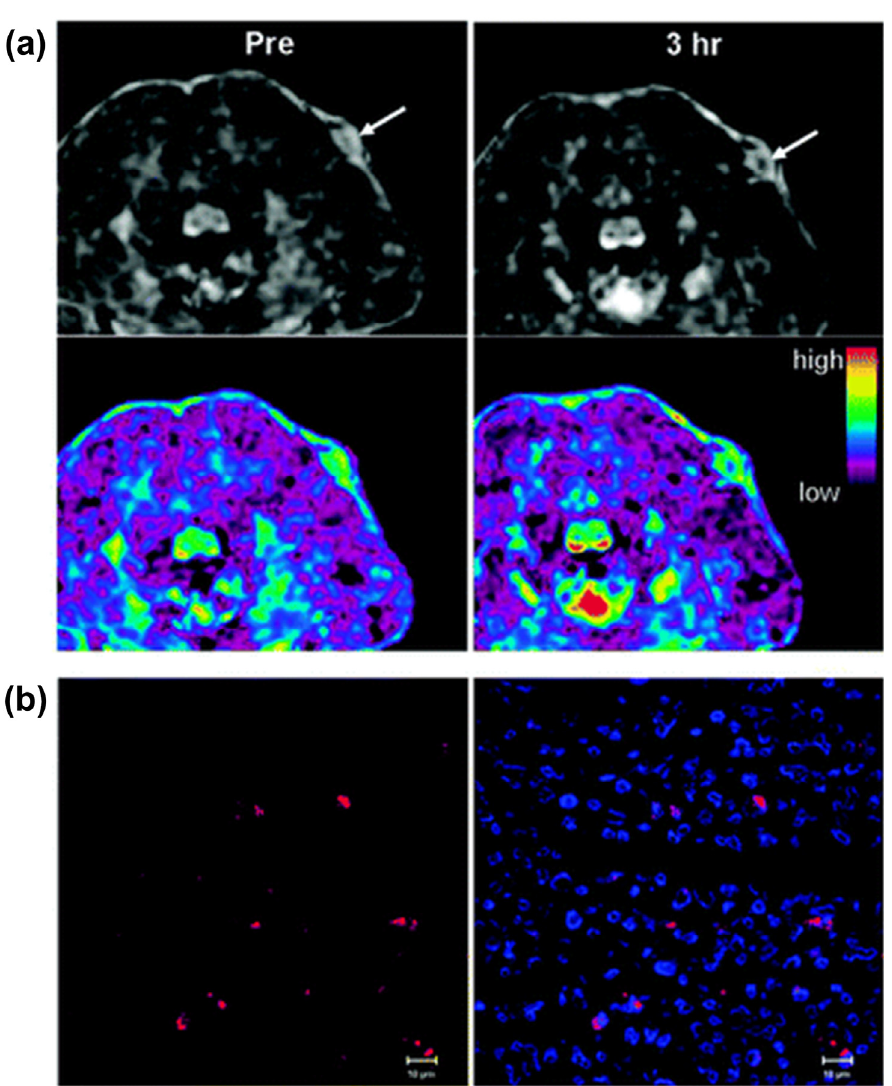
Figure 6. ( a ) In vivo MR images (upper) and color mapped images (lower) of the tumor site (indicated by arrows) before and 3 h after intravenous injection of PEG-coated Fe 3 O 4 -MSNs. ( b ) Confocal laser scanning microscopy images of sectioned tumor tissue harvested 24 h after intravenous injection of RITC-doped PEG-coated Fe 3 O 4 -MSNs (left) and merged with DAPI-stained nuclei (blue, right). Reproduced with permission from reference [23]. Copyright 2010 American Chemical Society.